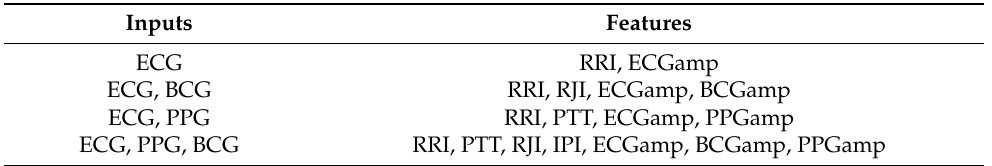
Table 2. Feature list of different inputs.